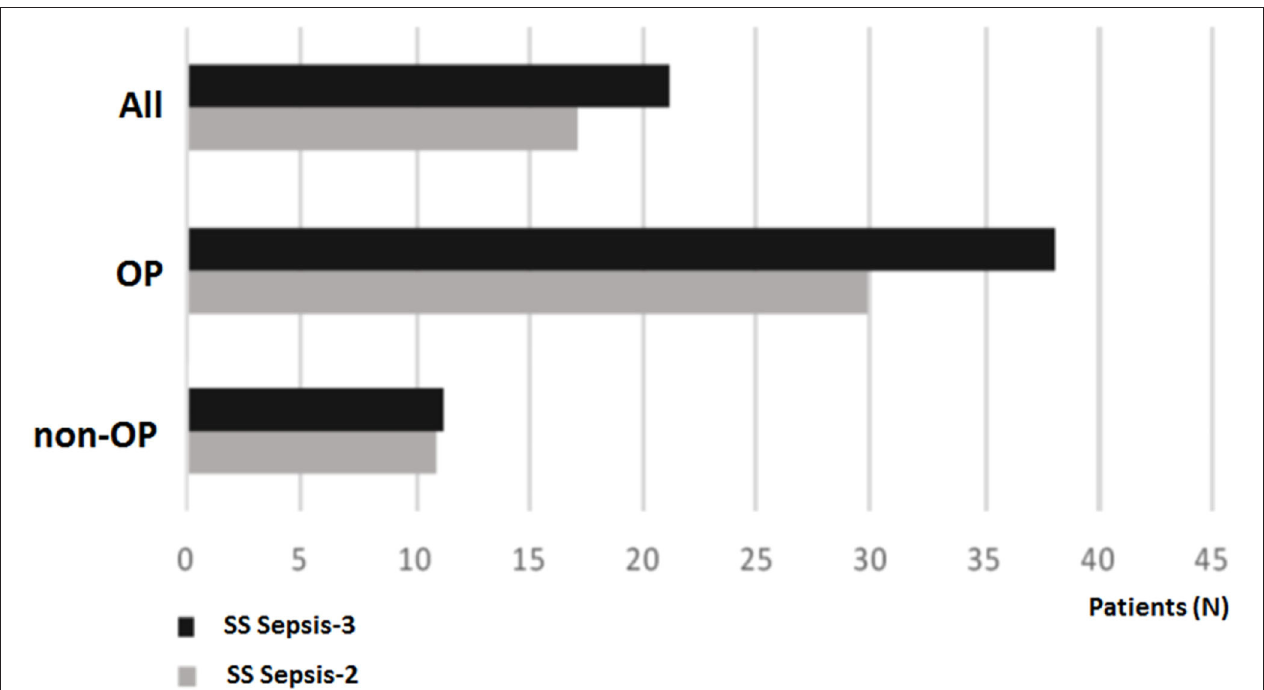
FIGURE 4 | Outcome in all patients, oncological patients (OP) and non-OP, according to septic shock task force definition. SS Sepsis-3, Septic shock according to Sepsis-3 task force; SS Sepsis-2, Septic shock according to Sepsis-2 task force.